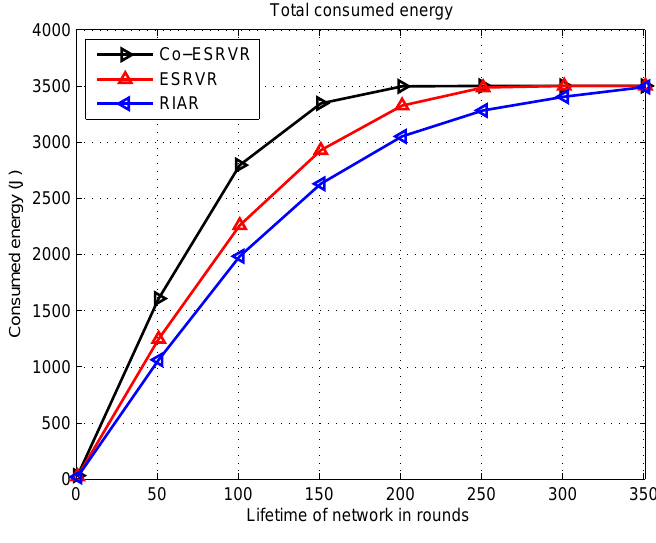
Figure 7. Consumed